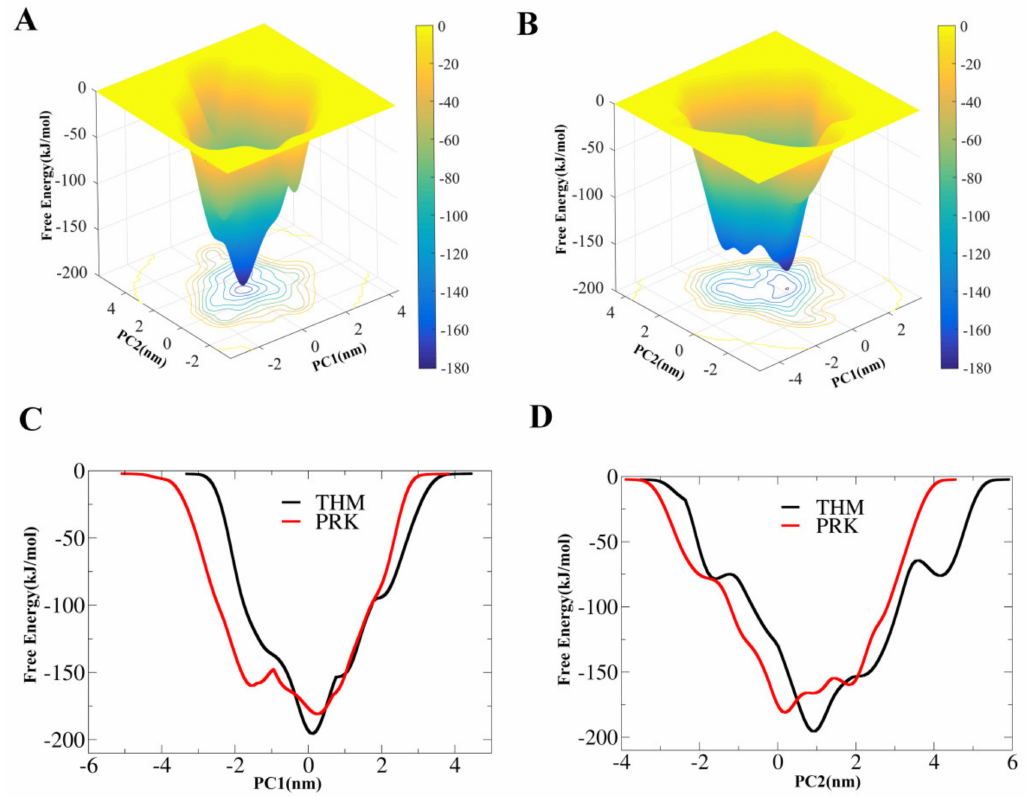
Figure 5. Constructed free-energy landscapes (FELs) of THM and PRK. ( A ) and ( B ) are 2D FELs for THM and PRK as a function of the first (PC1) and second (PC2) eigenvectors, respectively. The color bar represents the free-energy value in kJmol − 1 . ( C ) and ( D ) are 1D free-energy profiles for THM and PRK as a function of PC1 and PC2,